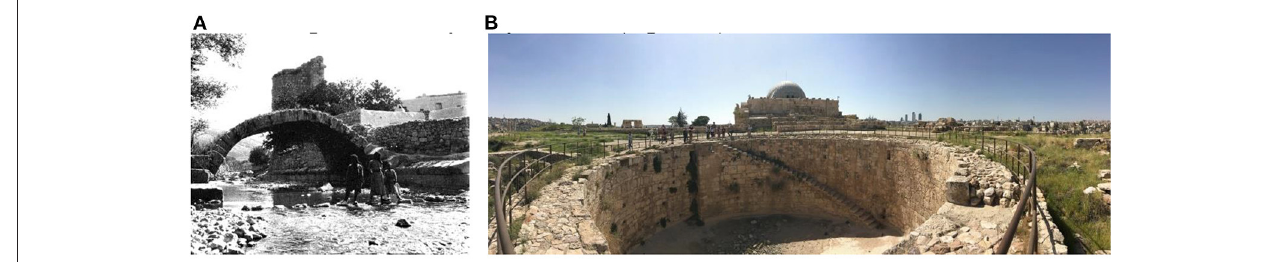
FIGURE 3 | (A) An historic photo from 1900 showing an historic bridge that crossed over the Amman Stream from the Classical era (photo credit: the History of Jordan); (B) The Umayyad period circular cistern atop the Citadel Hill (photo by Dr. Luna